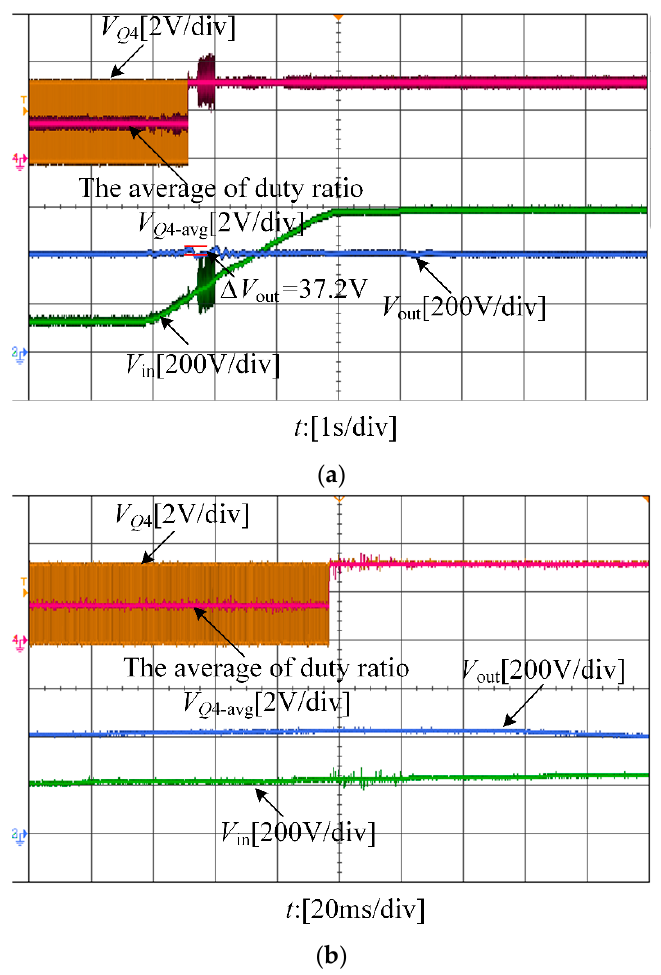
Figure 17. Experimental waveforms of transient switching process b with traditional control method. ( a ) Overall switching waveforms; ( b ) Enlarge detailed waveforms.